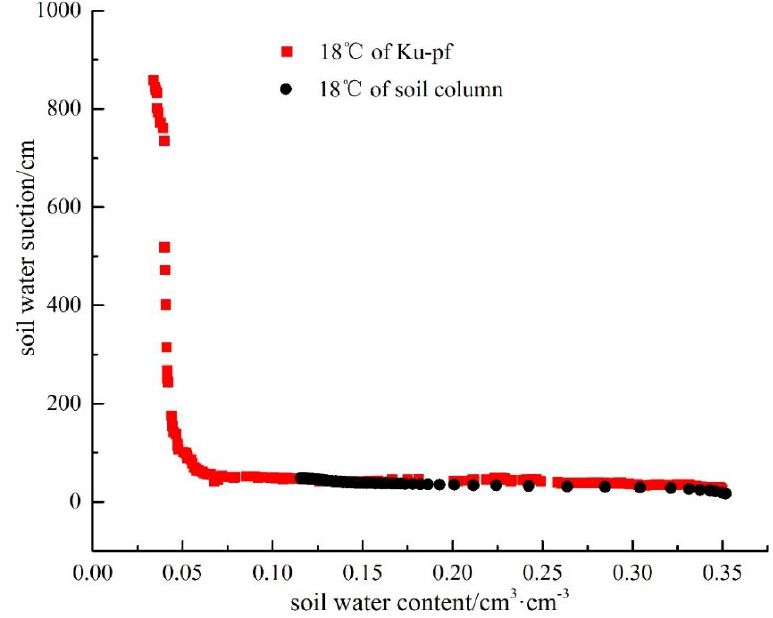
Figure 4. The experimental result of two different devices .